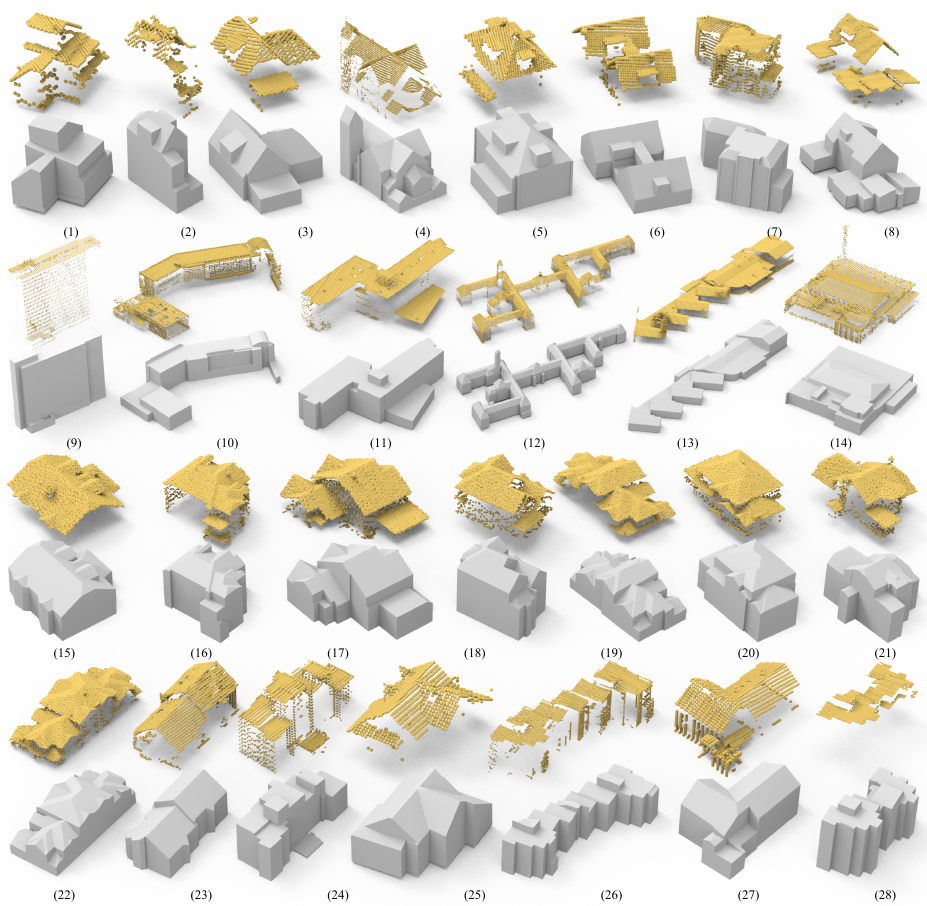
Figure 6. The reconstruction results of a set of buildings from various dataset. ( 1 – 14 ) are from the AHN3 dataset [21], ( 15 – 22 ) are from the DALES dataset [52], ( 23 – 28 ) are from the Vaihingen dataset